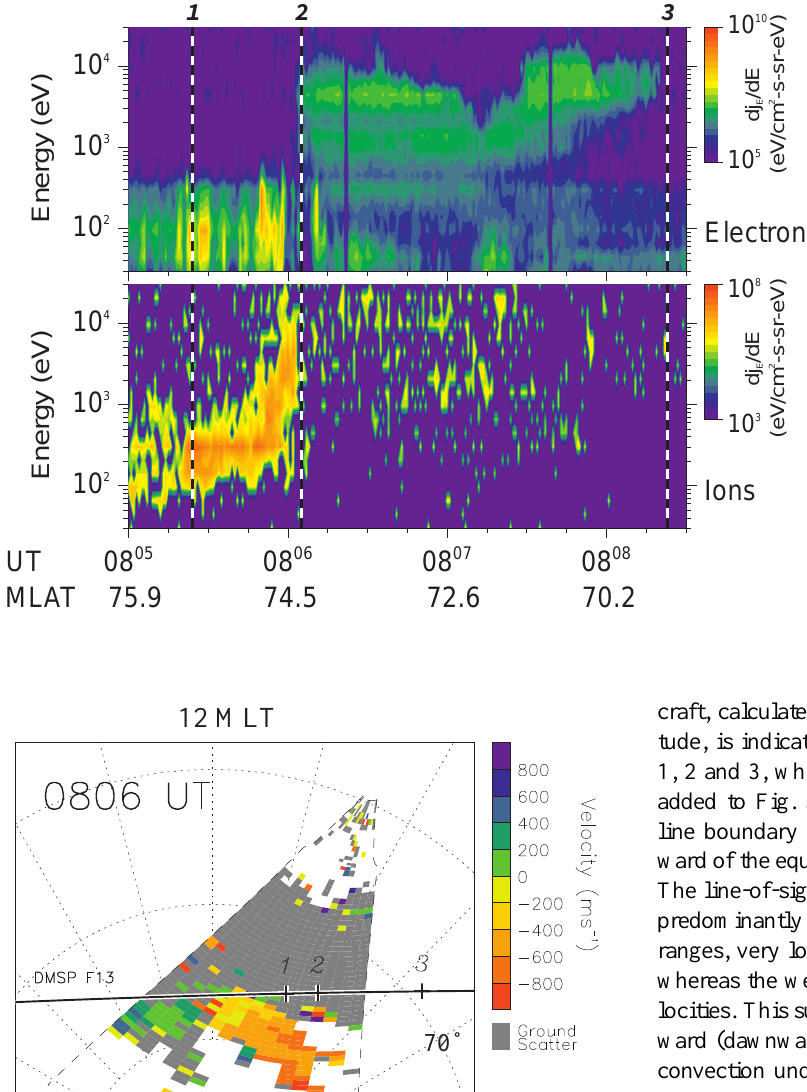
Fig. 6. Polar plot of the l-o-s velocity observed by the Hankasalmi radar at 08:06 UT, as a function of magnetic latitude and magnetic local time. Overlaid is a black line showing the footprint of the DMSP spacecraft. The ticks labelled 1, 2 and 3 shows the position of the spacecraft at 08:05:20, 08:06 and 08:08:20, respectively (as in Fig.